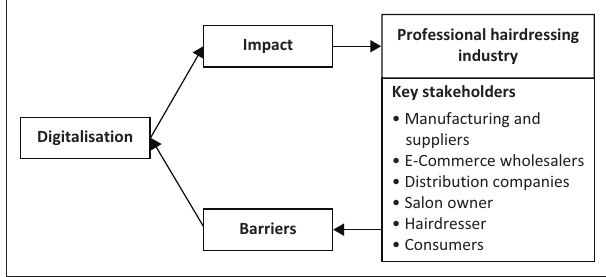
FIGURE 3: Thematic analysis on the hairdressing industry in South